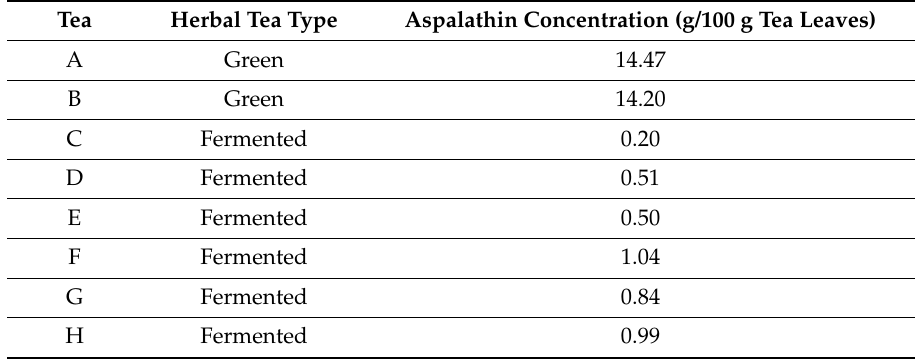
Figure 5. TLC analysis of samples from A) two green (lanes A and B) and six fermented (lanes C–H) rooibos herbal tea brands. Analysis was performed in duplicate. Asp: aspalathin standard, S: solvent front. Table 2. Aspalathin concentrations (g/100 g plant dry weight) determined by HPLC-DAD in green and fermented rooibos herbal tea extracts.